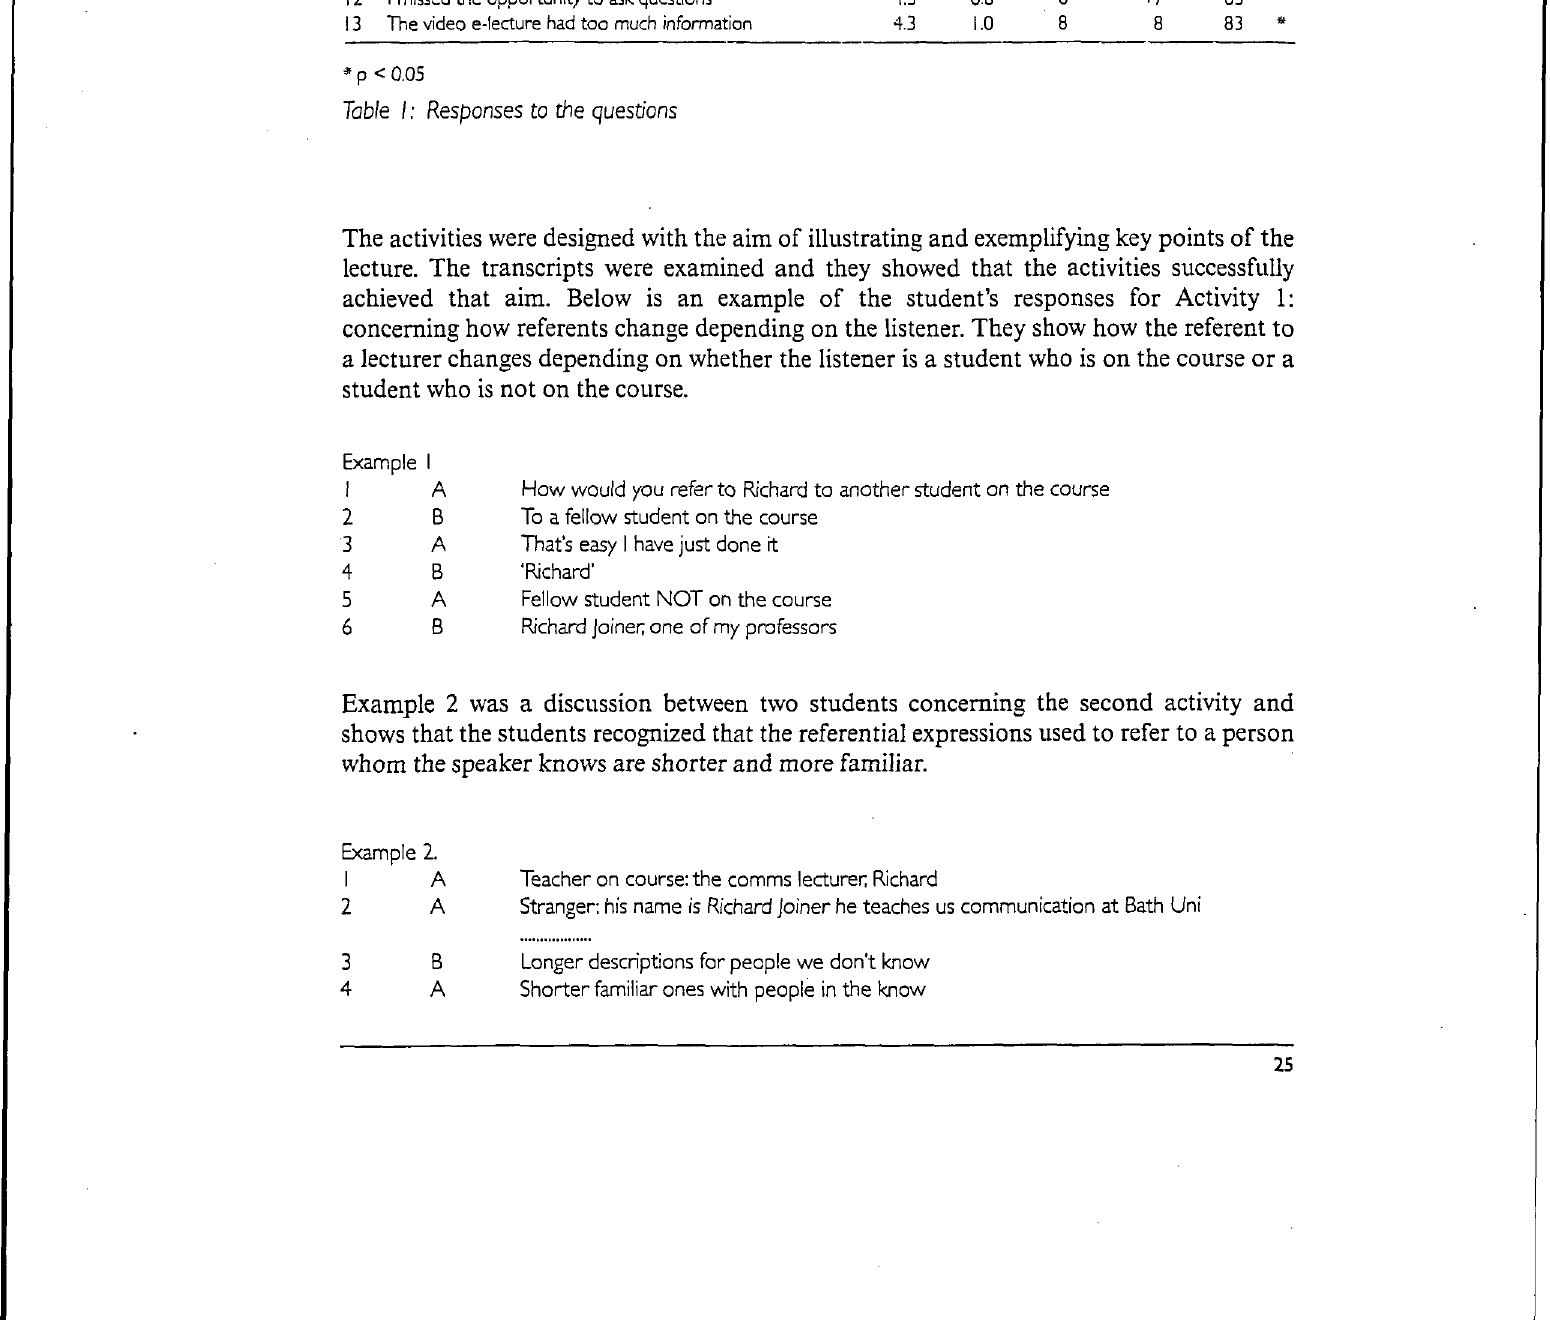
Table I: Responses to the